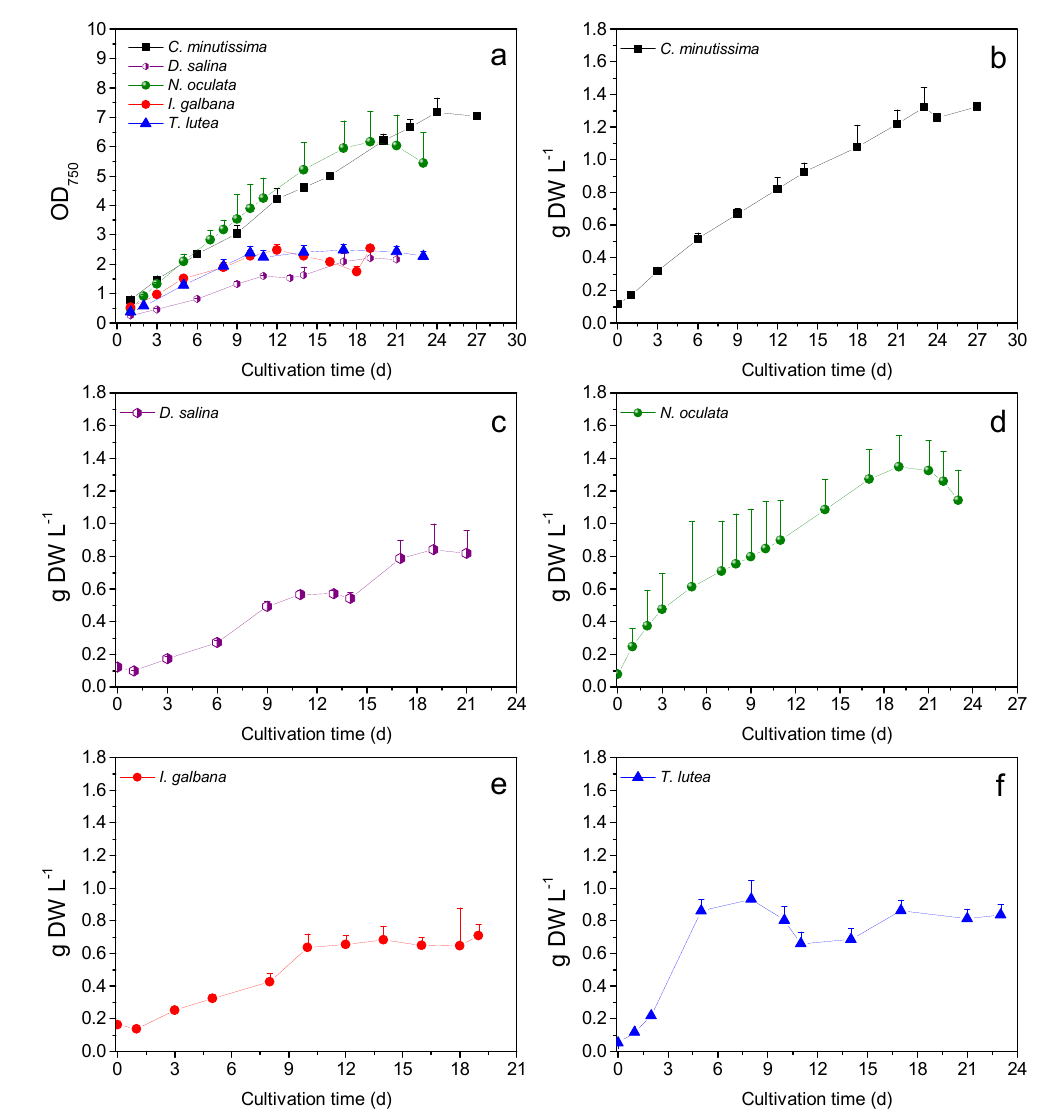
Figure 1. OD 750 ( a ), and TSS concentration values upon cultivation of the marine microalgal species C. minutissima ( b ), D. salina ( c ), N. oculata ( d ), I. galbana ( e ), and T. lutea ( f ).